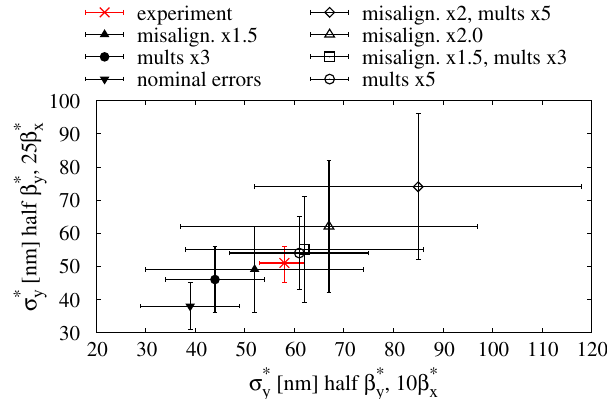
FIG. 11. The IP beam sizes measured in ATF2 (red) and obtained with simulations without the orbit correction (black) for half β (cid:1) y , 10 β (cid:1) x and half β (cid:1) y , 25 β (cid:1) x